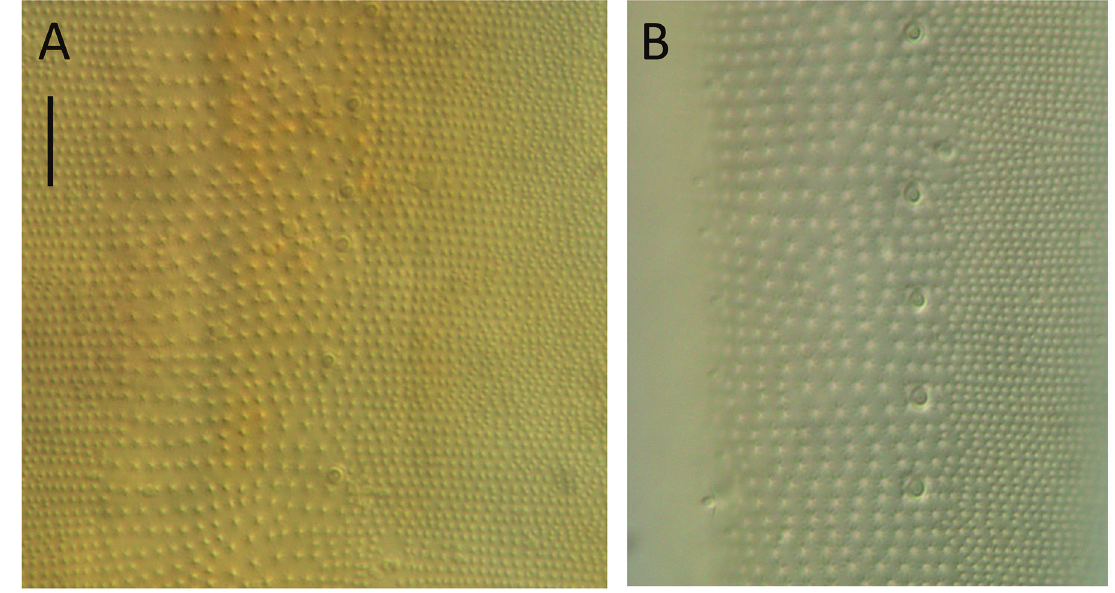
Fig. 9. Halichoanolaimus funestus sp. nov. Light micrographs of paratype ♀ (NIWA 139249). A . Cuticle in mid-body region showing arrangement of pore complexes. B . Cuticle near tail region showing arrangement of pore complexes. Scale bar = 10